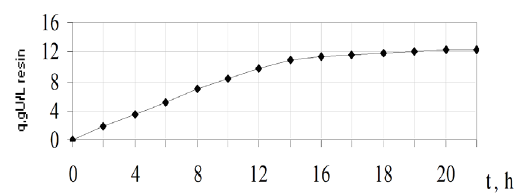
Figure 4. The dynamics of isothermal saturation with uranium (VI) of Purolite resin SG 600 U / 3472. i) anions solution composition: (i) U (VI) -0.66 g L -1 , CO 32- -8.97 g L -1 , HCO 3- -8.85 g L -1 , SO 42- -32 g L -1 ; ii) t=20 0